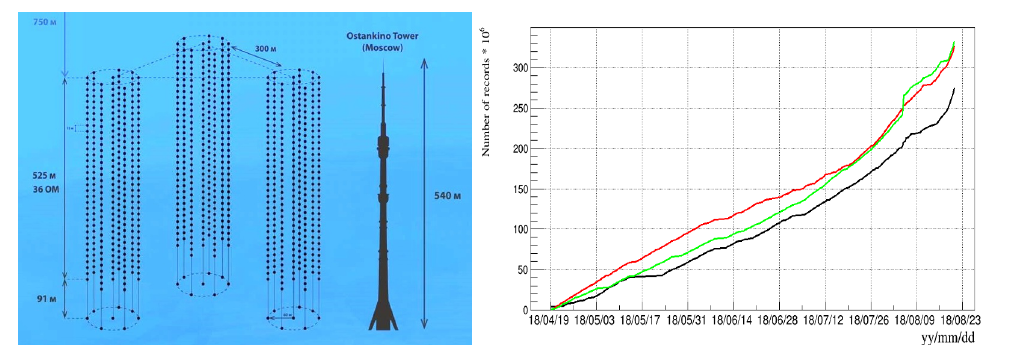
Figure 1. Left: Schematic drawing of the Baikal-GVD three clusters operated in 2018. Right: Integrated number of events recorded by the clusters in period of April 10–September 2 of